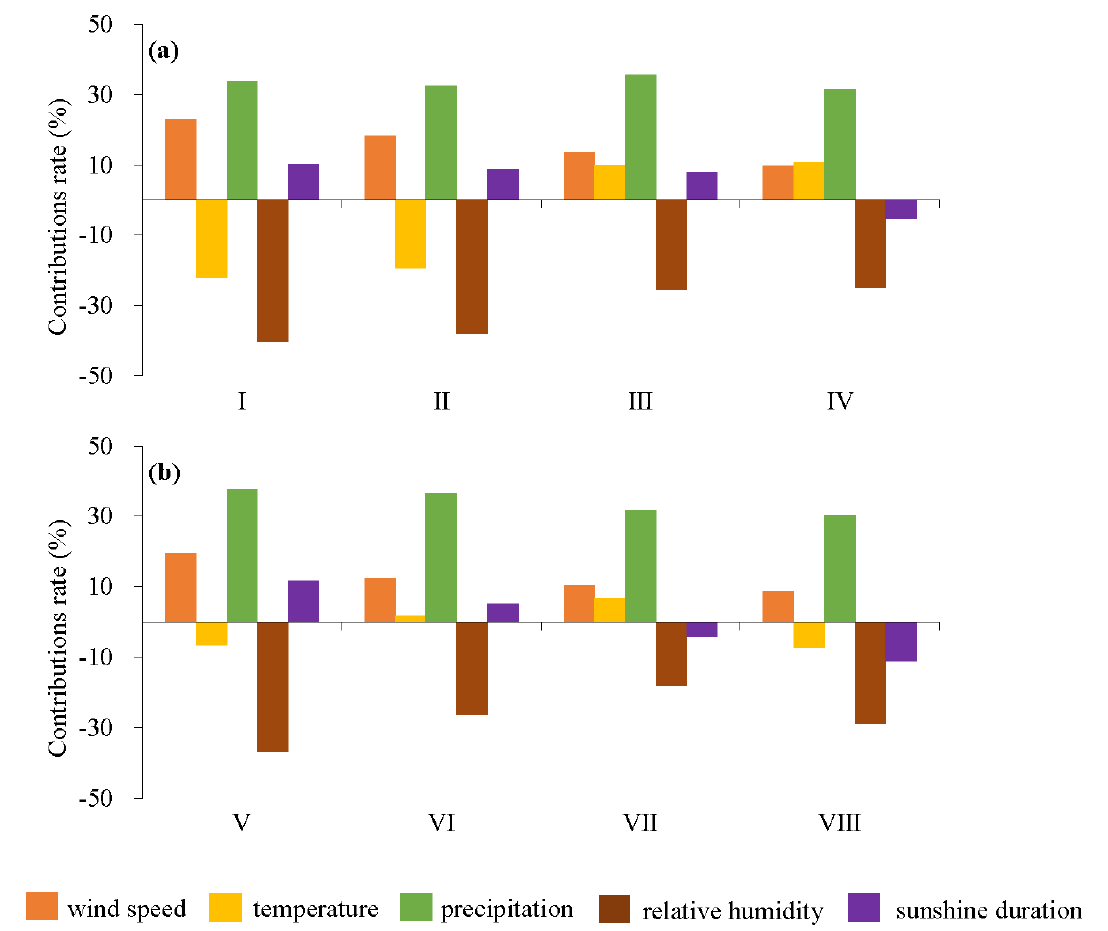
Figure 10. The average contribution rates of climatic factors for different climatic and moisture regions during 2001 − 2020. ( a ) The average contribution rates of climate change for different thermal regions. I, II, III, and IV are tropical regions, subtropical regions, temperate regions, and plateau climate regions, respectively; ( b ) the average contribution rates of climate change for different moisture regions. V, VI, VII, and VIII are humid regions, semi-humid regions, semi-arid regions, and arid regions, respectively.